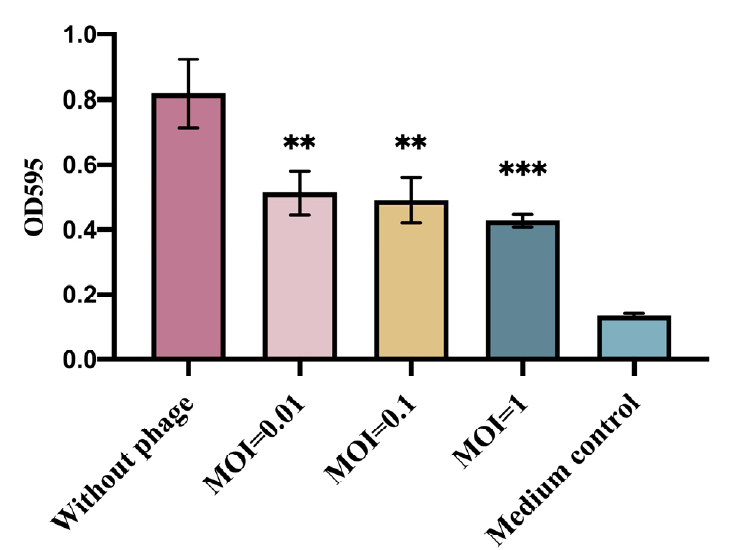
Figure 3. Inhibition of bacterial biofilm formation by phage vB_EcoS_GN06. The columns in the figure represent Control (without phage), The experimental groups added with phage at MOI = 1, 0.1 and 0.01, and medium control, respectively (**: p < 0.01, ***: p < 0.001).